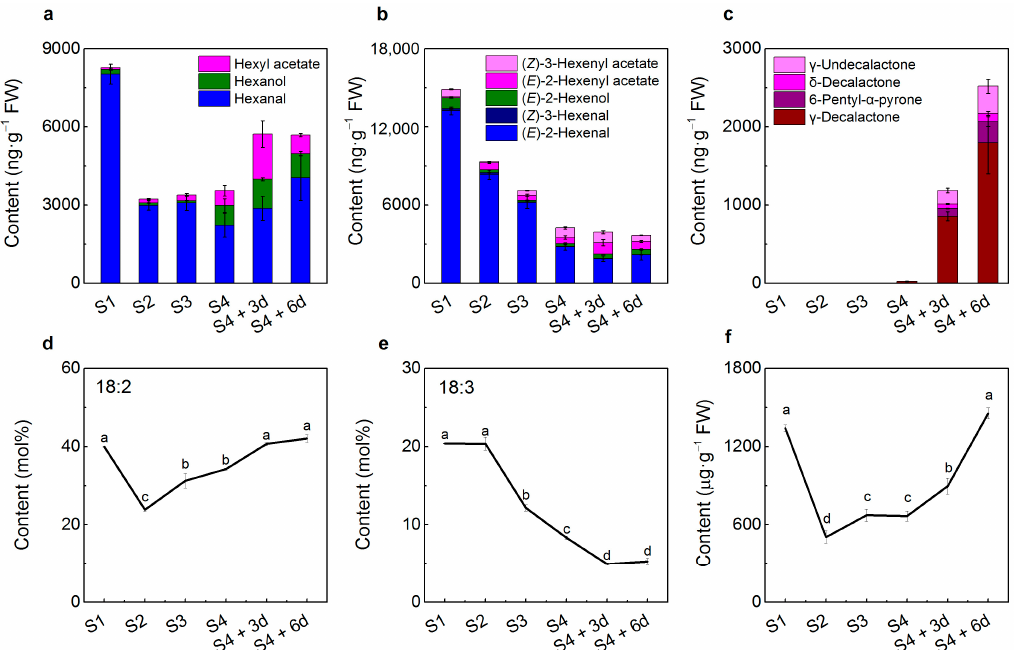
Figure 1. The contents of peach fruit volatiles and fatty acids during development and ripening. ( a ) Contents of volatile compounds derived from 18:2; ( b ) volatile compounds derived from 18:3; ( c ) lactones from fatty acids; ( d ) content of 18:2; ( e ) content of 18:3; ( f ) content of total FAs. Relative quantification of volatile compounds was performed using the peak area of the internal standard as a reference. Data are the mean ± stand error from three replicates. Values indicated by different letters represent significant difference at level of 0.05.